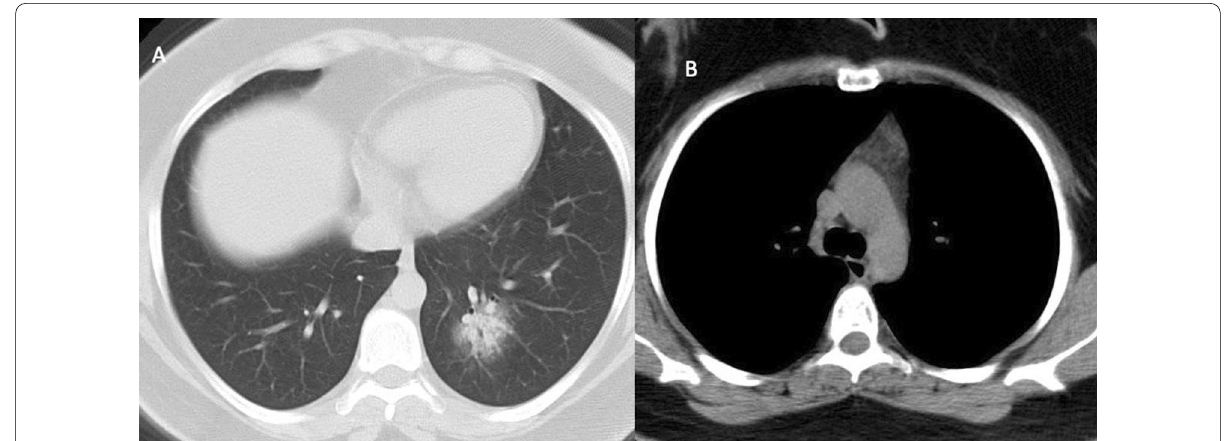
Fig. 1 26-year-old female COVID-19 (